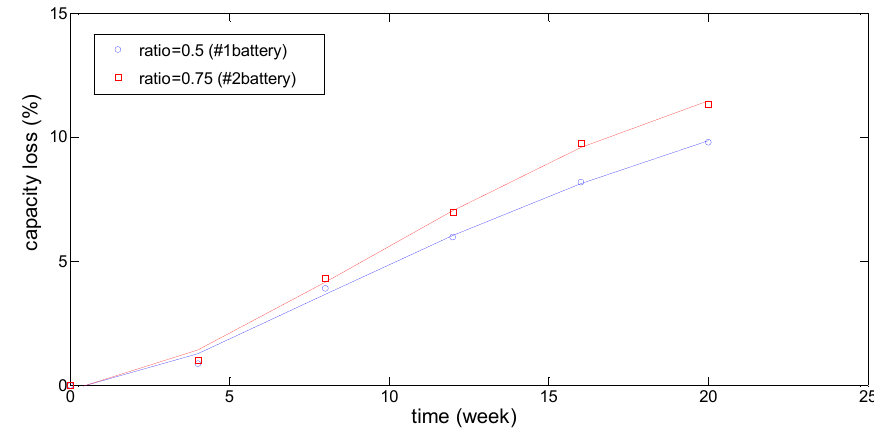
Figure 3. Proportion of capacity loss varying with time for ratio = 0.5 and 0.75, respectively.